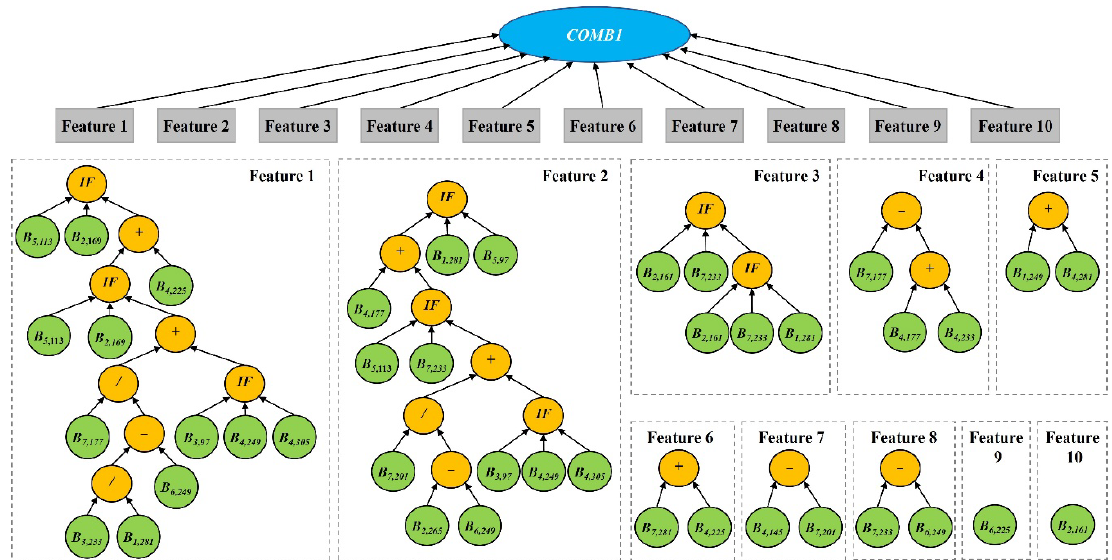
Figure 10. Example of 10 features learned by GP.